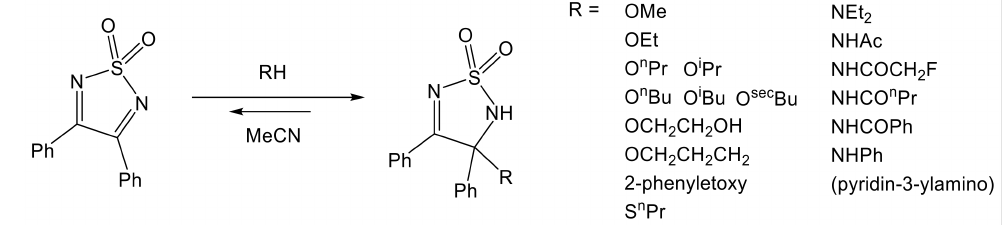
Figure 5. Addition of soft nucleophiles (primary and secondary alcohols, amines, and primary amides) to the C=N double bond of 3,4-diphenyl 1,2,5-thiadiazole 1,1-dioxide [68,82–86].